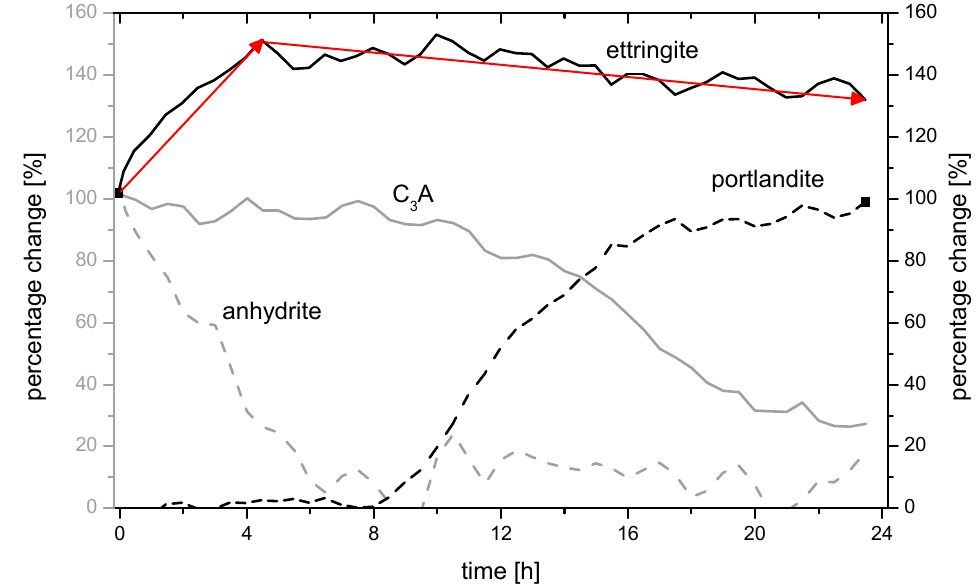
Figure 9. In ‐ situ XRD ‐ measurement of the mpc for different phases in sample C7_4.50_75/25. Both samples have comparable ettringite stability (130–140%). However, sample C7_4.50_25/75 with an increased proportion of anhydrite has a compressive strength of 77.3 N/mm 2 , which is 4.8 N/mm 2 higher than sample C7_4.50_75/25 with an increased proportion of